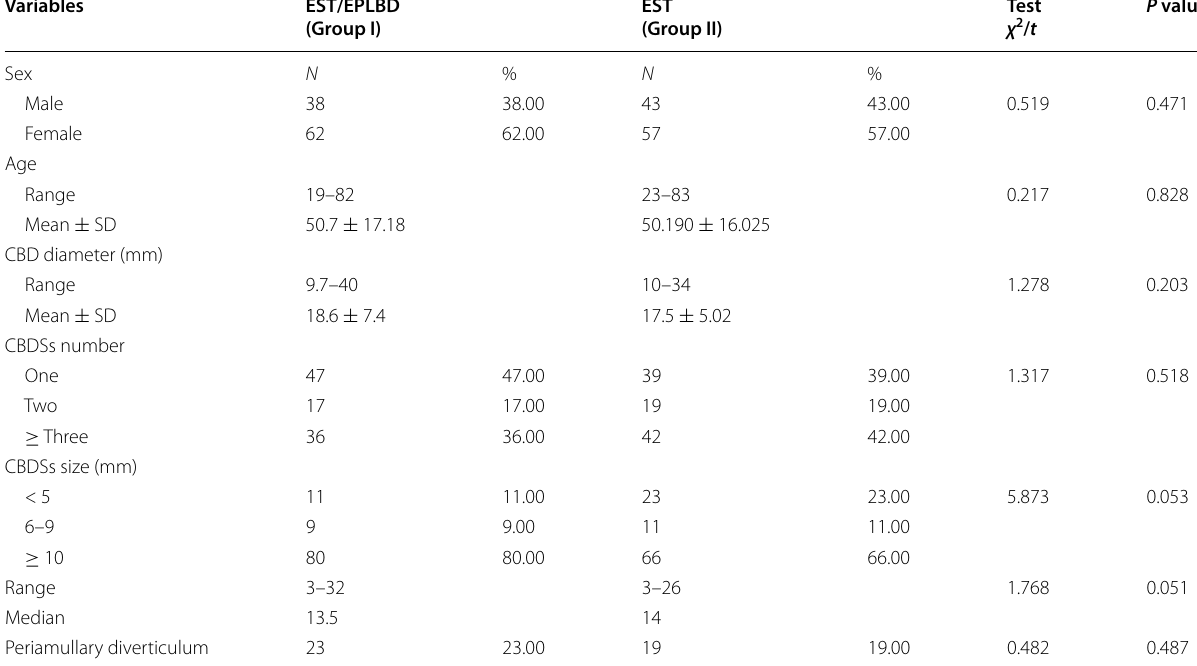
Table 1 Characteristics of the patients Variables